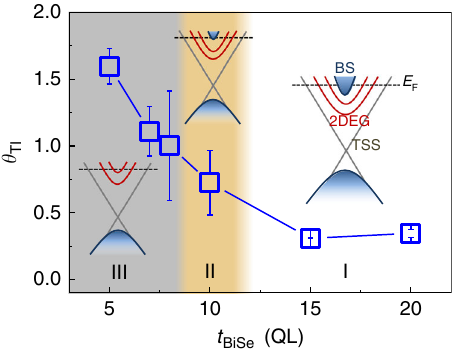
Fig. 2 ST-FMR measurements and signals with fi ts. a Schematic diagram of the ST-FMR measurement setup, illustrating a ST-FMR device and the Fig. 3 The SOT ef fi ciency ( θ TI ) as a function of Bi 2 Se 3 thickness ( t BiSe ) at measurement circuit. An rf current from a signal generator (SG) is injected room temperature. Each θ TI represents the averaged value from three into the ST-FMR devices via a bias-tee. b Illustration of spin momentum devices. The error bars are the standard deviation. Region I, II, and III locking and SOT-induced magnetization dynamics in the ST-FMR denoted by different colors represent the charge-to-spin conversion measurements. The big blue arrow denotes the electron moving direction dominated by different mechanisms. The inset shows the schematic of the (opposite to I RF direction). The arrows with green and red balls denote the band structure for each region spin angular momentum generated at top and bottom surfaces of Bi 2 Se 3 , respectively. c A typical ST-FMR signal (open symbols) from a Bi 2 Se 3 20 QL/CFB 7 nm device at 6 GHz with fi ts (solid lines), where the blue and green lines represent the symmetric Lorentzian ( V S F S ) and antisymmetric Lorentzian ( V A F A ) components, generated at the Bi 2 Se 3 surfaces denoted by the arrows with green and red balls. These spins from Bi 2 Se 3 top surface diffuse into CFB and exert oscillating damping-like torque ( τ DL ) and/or a fi eld-like torque ( τ FL ) on the magnetization. These torques toge- ther with rf current-induced Oersted fi eld ( H RF ) torque ( τ Oe ) trigger the precession of CFB magnetization and an oscillation of the anisotropic magnetoresistance with the same frequency as I RF .